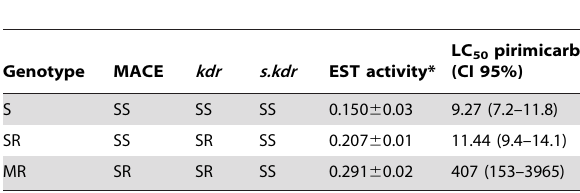
Table 1. Characterization of the Myzus persicae genotypes selected for microarray